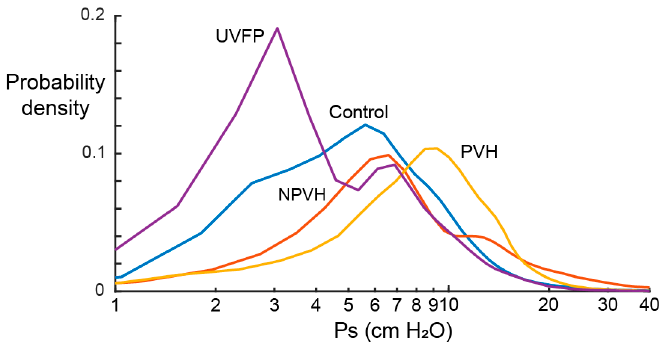
Figure 5. Ambulatory subglottal pressure probability density for each participant group using Ps Estimation Method 3.